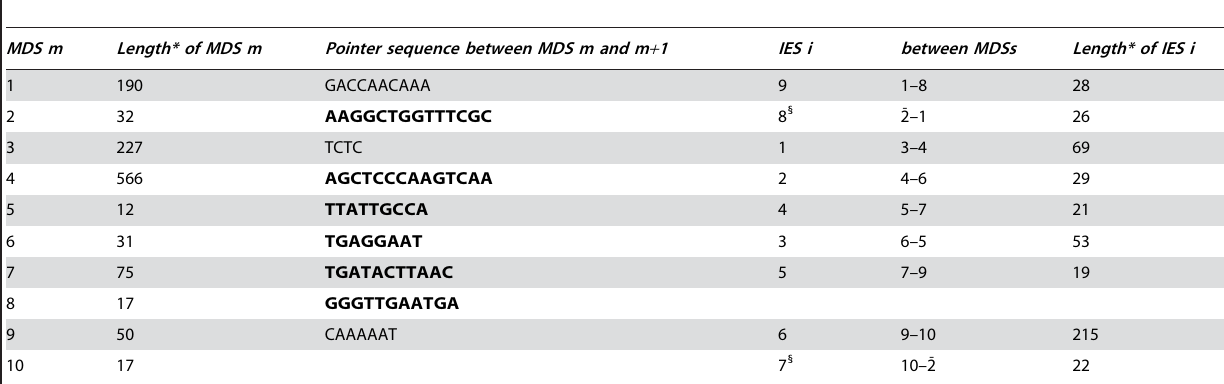
Table 2. Characteristics of MDSs, IESs, and pointers of the O. trifallax actin I gene.